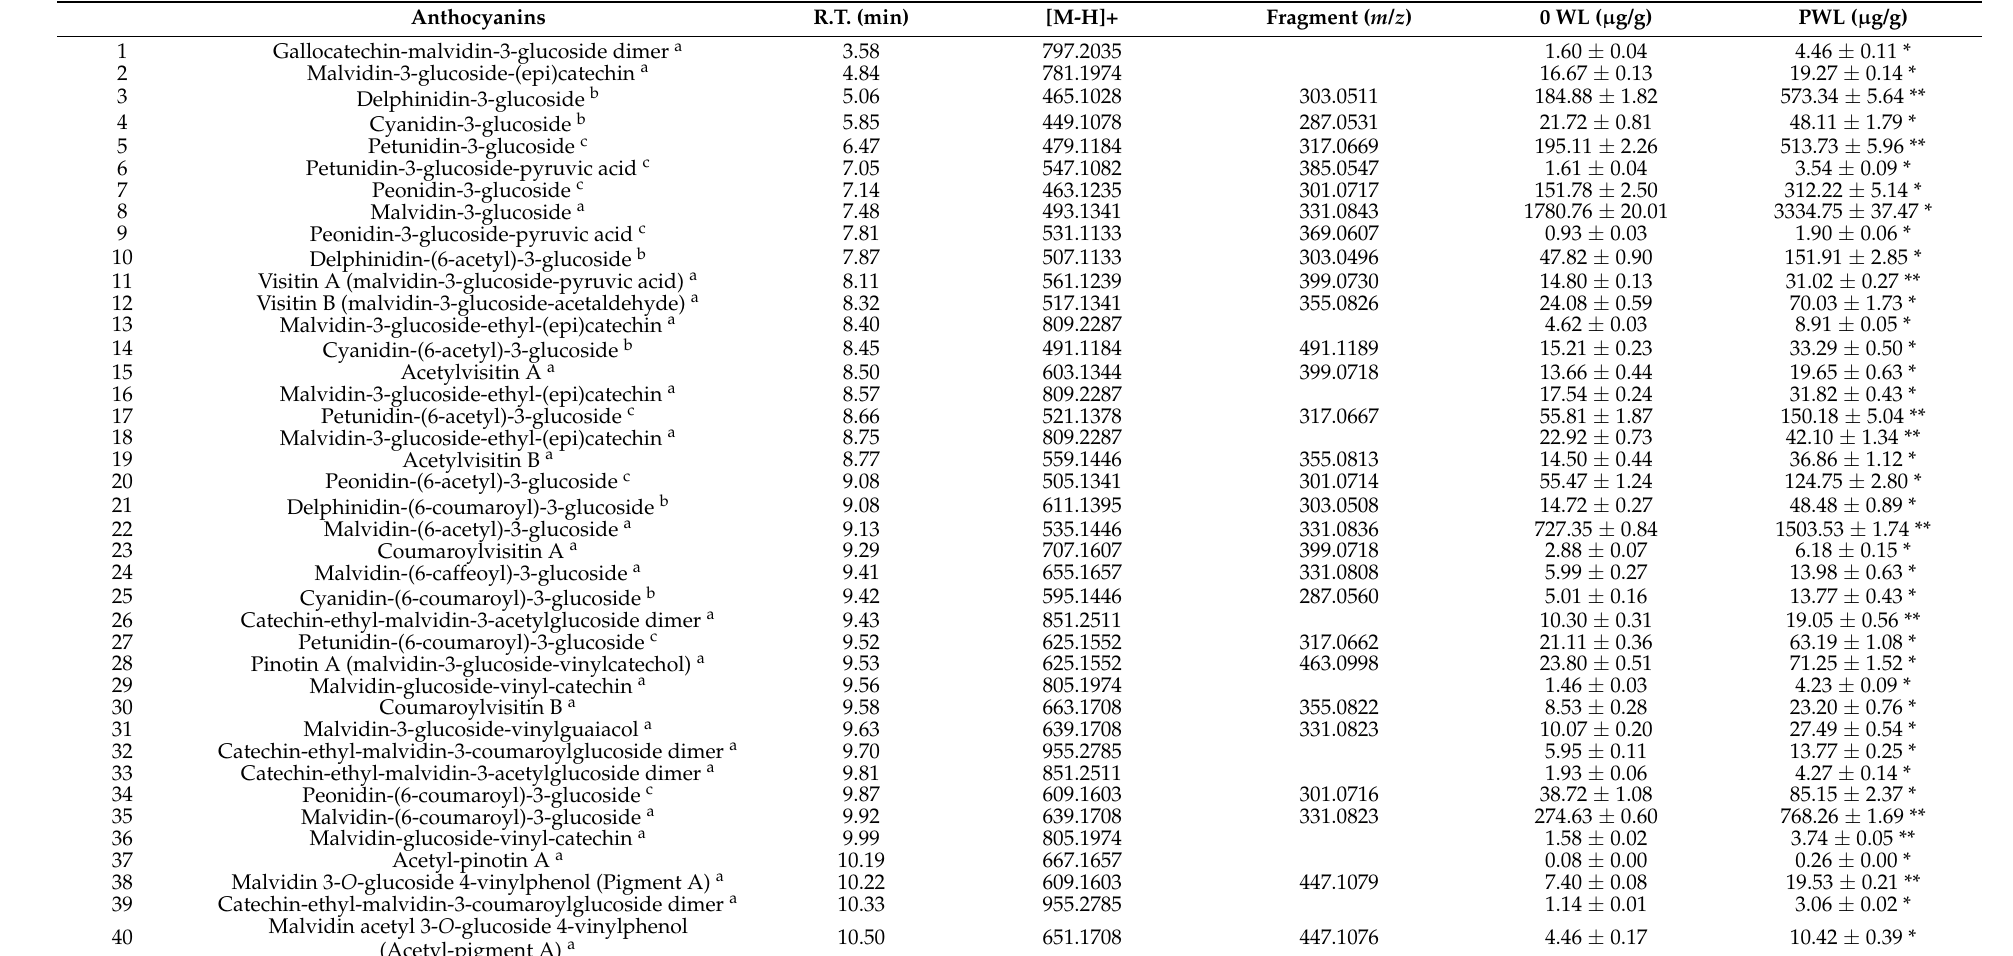
Table 3. Anthocyanin characterization by UHPLC-(ESI+)-Q-TOF-MS in 0 WL and